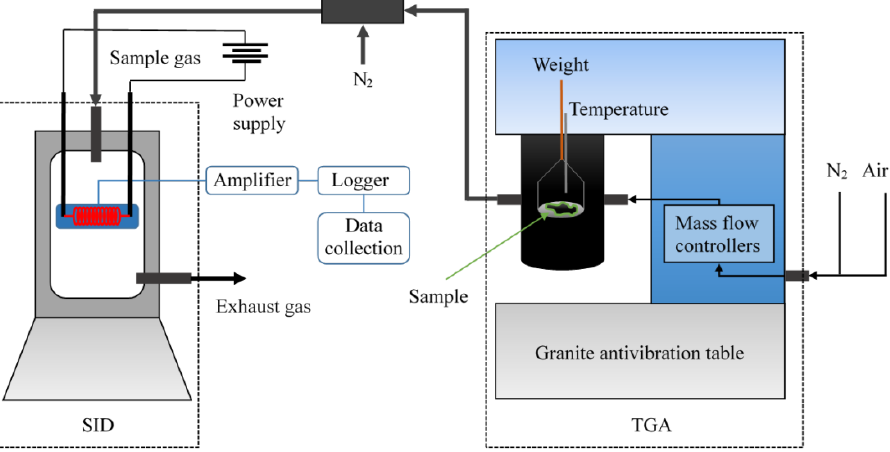
Figure 1. The experimental TGA-SID setup used for the simultaneous characterization of alkali re- lease and mass loss from a selected sample. The main components of the SID are a hot Pt filament (coiled wire marked in red) and a nearby ion collector plate (blue area behind red wire); see text for the details.